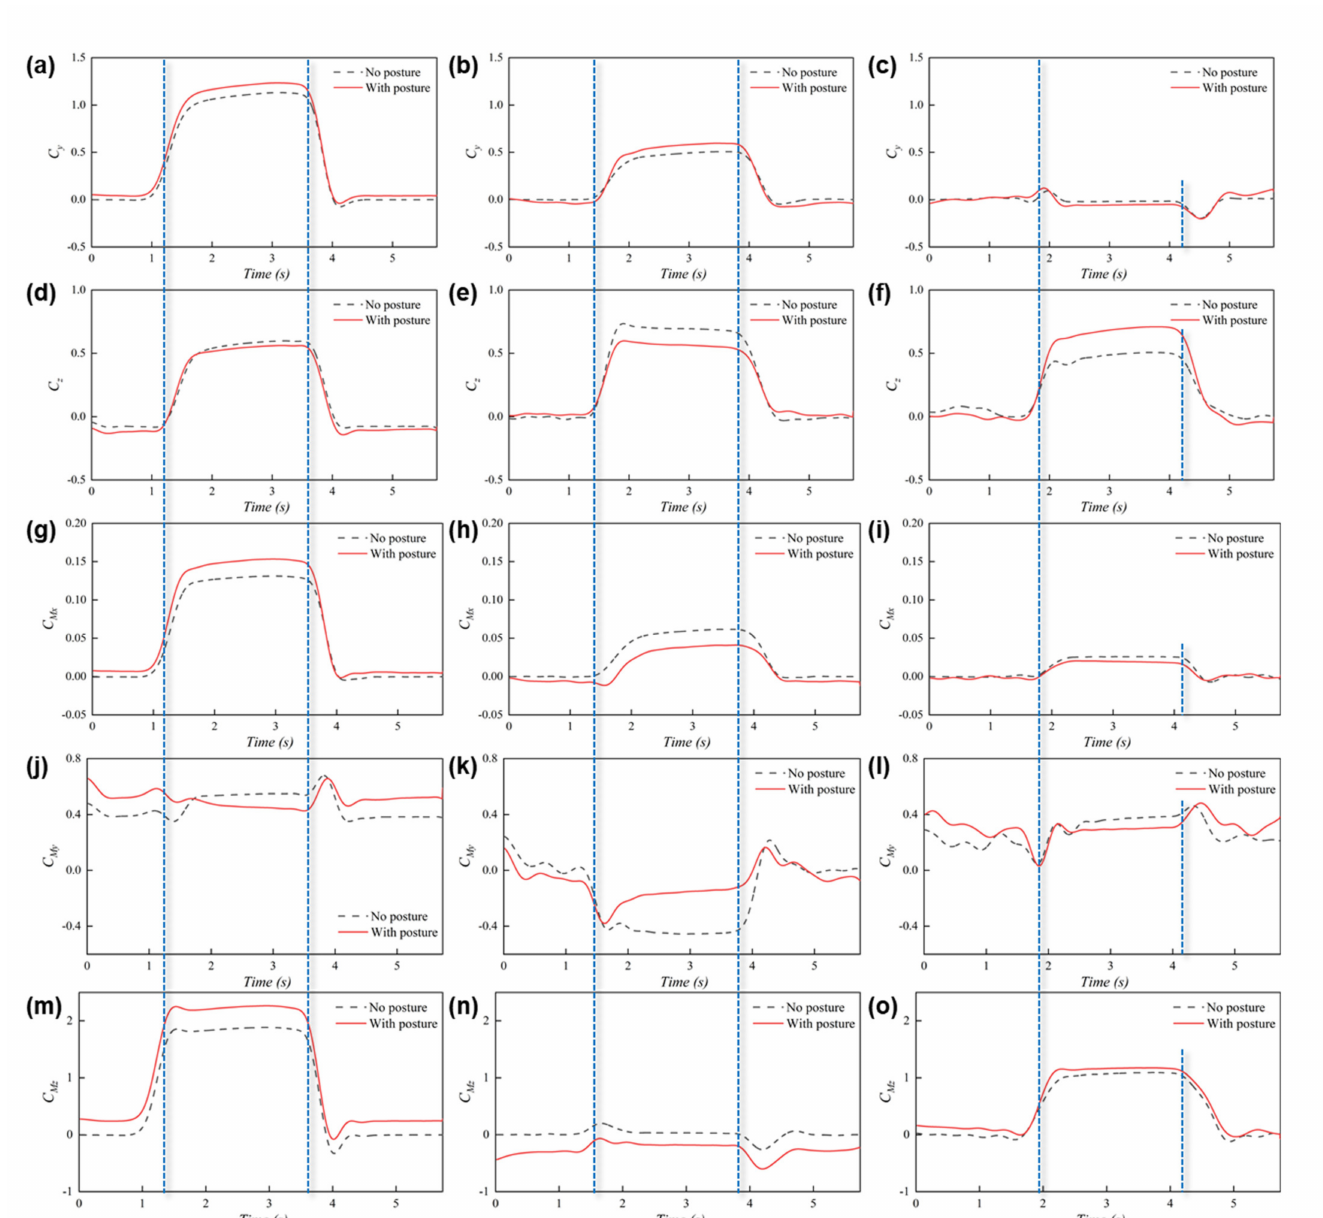
Figure 7. The time-varying aerodynamic coefficients of each car passing the crosswind with and without posture: ( a ) C y of the leading car; ( b ) C y of the middle car; ( c ) C y of the trailing car; ( d ) C z of the leading car; ( e ) C z of the middle car; ( f ) C z of the trailing car; ( g ) C M of the leading car; ( h ) C M of the middle car; ( i ) C M of the trailing car; ( j ) C M of the leading car; x x x y ( k ) C M of the middle car; ( l ) C M of the trailing car; ( m ) C M of the leading car; ( n ) C M of the middle car; ( o ) C M of the y y z z z trailing